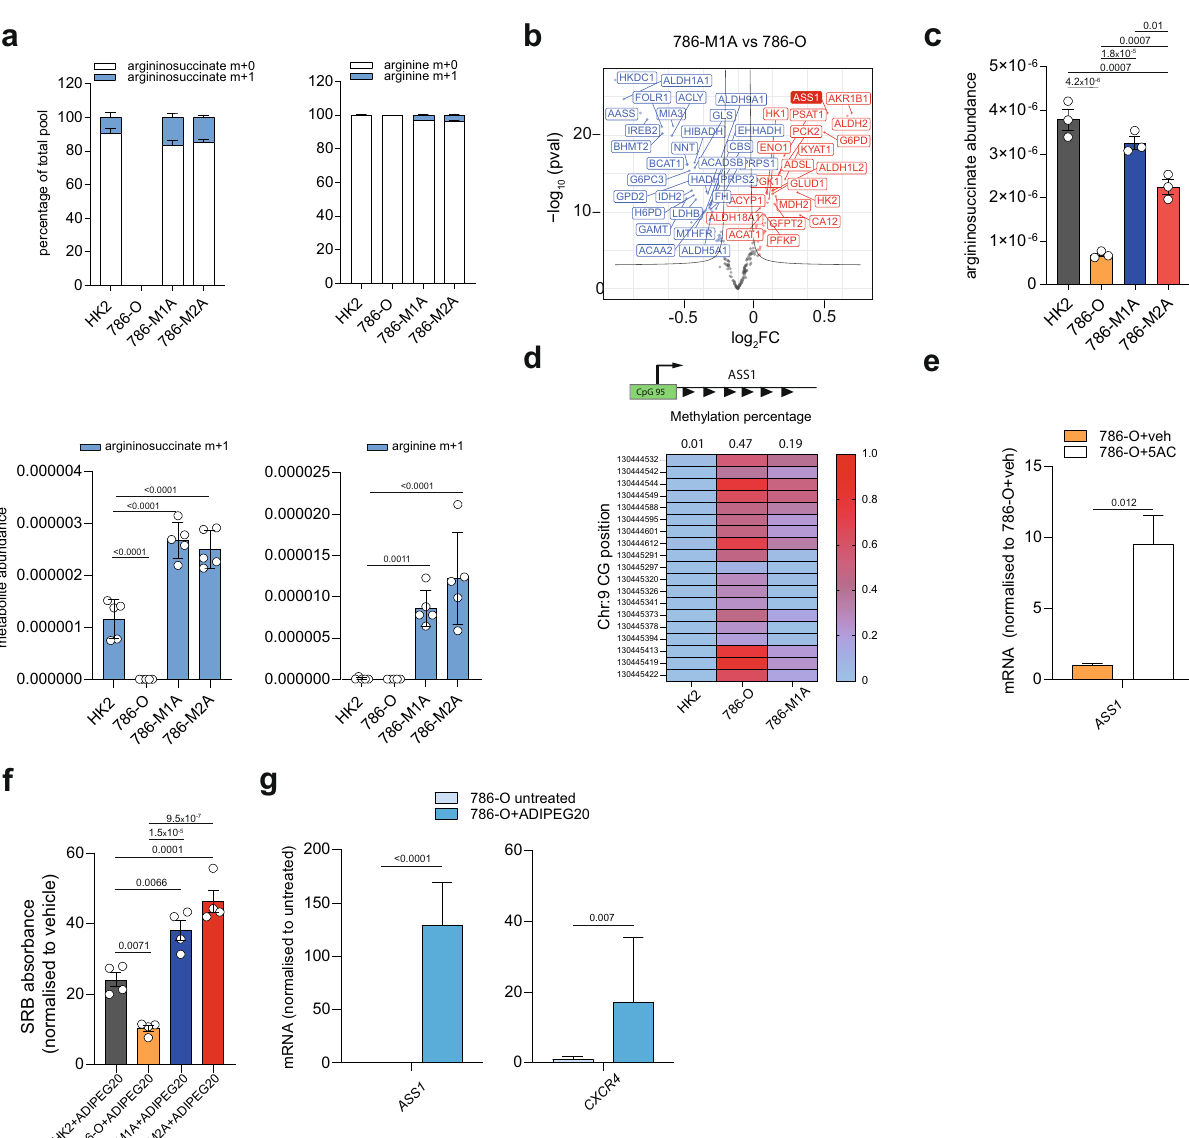
treated for 72h with either vehicle or 200nM 5AC measured through qPCR. TBP was used as endogenous control. Values represent relative quanti fi cation (RQ)± error calculated using Expression suite software (Applied biosystem) calculated usingSDalgorithm. p -valuewascalculatedthroughExpressionsuitesoftware. N =3 independent experiments. f Measurement of cell proliferation through Sulforho- damine B (SRB) staining after treatment with pegylated arginine deiminase (ADI- PEG20, 57.5ng/ml) at the indicated concentrations for 48h. Values of SRB absorbance are shown as fold-change±S.E.M. relative to vehicle-treated staining. p -values were calculated using one-way ANOVA with multiple comparisons. N =4 independent experiments. g mRNA levels of ASS1 and CXCR4 in786-O treated